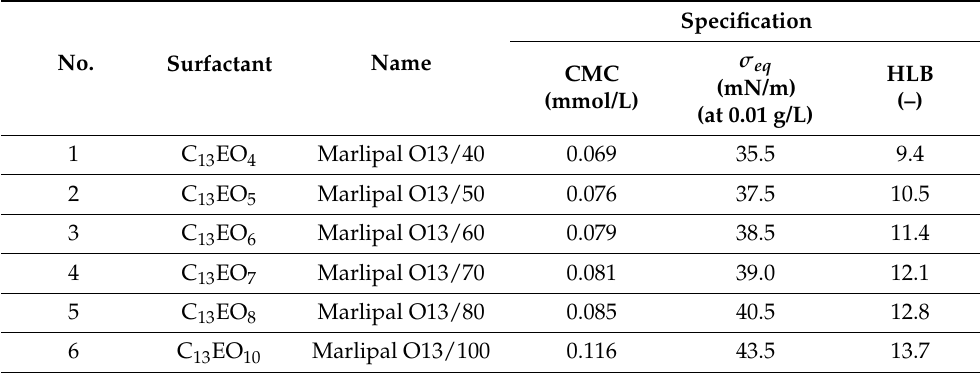
Table 1. Characteristic data of nonionic surfactants with different lengths of hydrophilic EO head groups but the same hydrophobic chain mixture of C 12 and C 14 . All surfactants were supplied by Sasol, Germany.